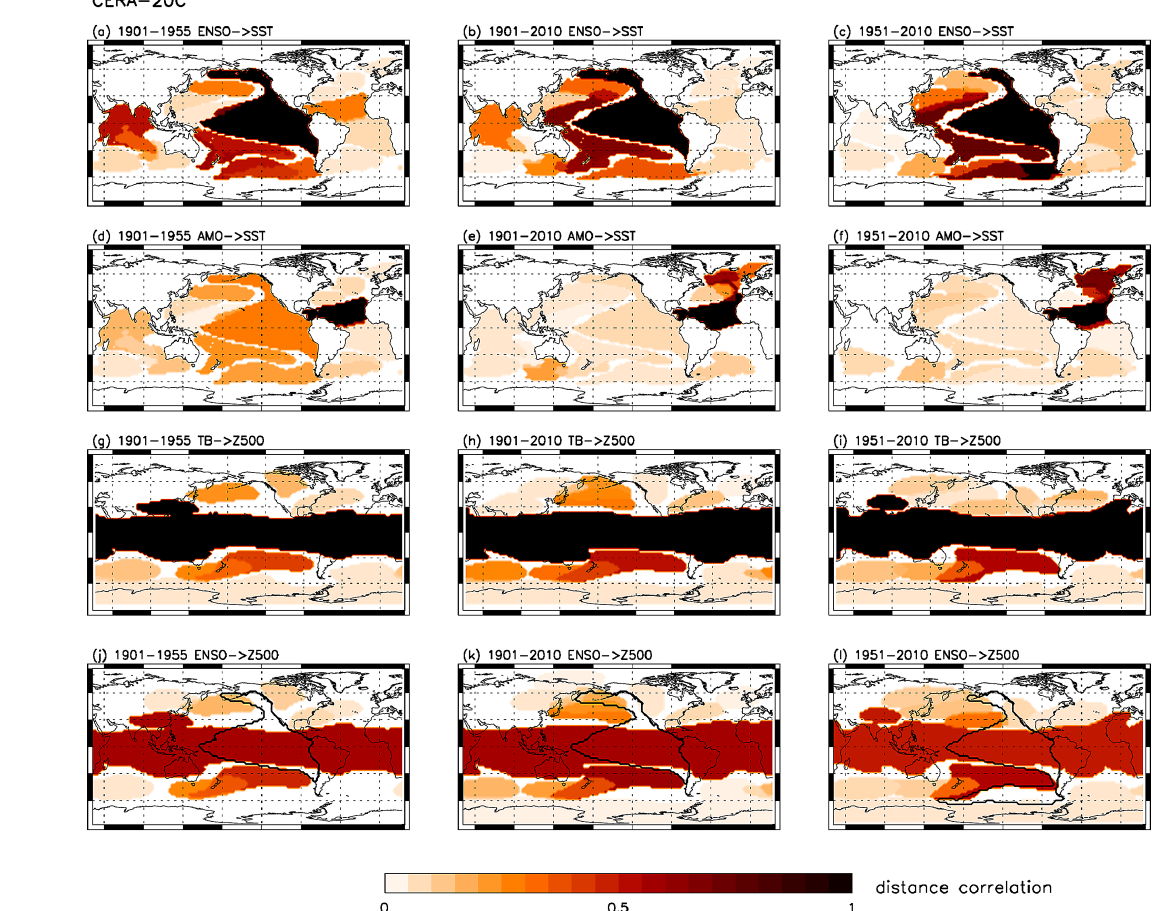
Figure 3. Spatially distributed maximum lagged distance correlation links and cross-links between SST and/or Z500 domains in CERA-20C. (a–c) ENSO (black) to SST domains; (d–f) North Tropical Atlantic (AMO; black) to SST domains; (g–i) Tropical Belt (TB; black) to Z500 domains; (j–l) ENSO (contoured) to Z500 domains. (a, d, g, j) Time period 1901–1955, (b, e, h, k) time period 1901–2010, (c, f, i, l) , time period